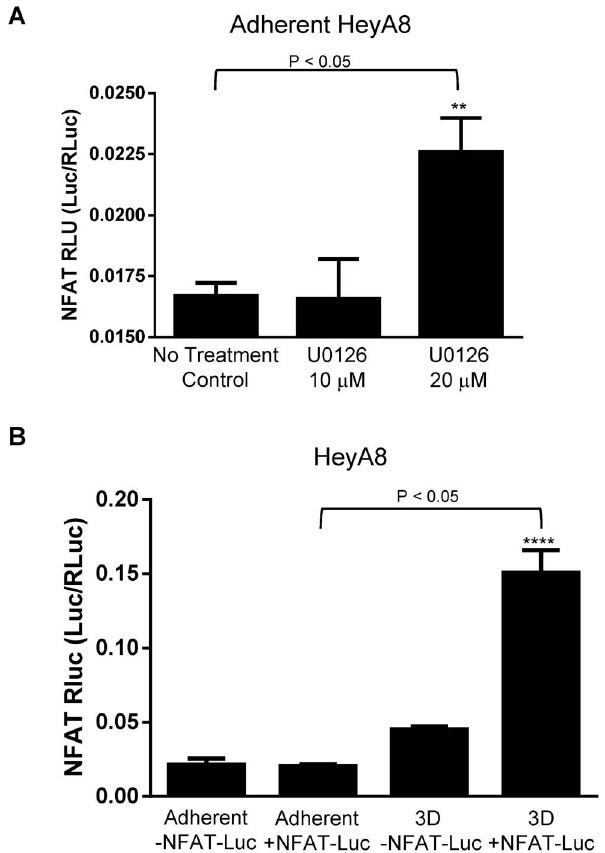
Fig. 7. ERK inhibition and 3D spheroids increased NFAT transactivation. HeyA8 cells plated at 50,000 cells in a 24 well plate for transfections. 500 ng of NFAT-Luc/Renilla mixture (40:1) were transfected per well and incubated overnight. U0126 were treated for 16-24 hours and 3D spheroids were formed for 48 hours prior to luciferase assay. ( A ) U0126 treated adherent HeyA8 cells showed slight significant increase of NFAT transactivation at the 20 m m but not at 10 m m. ( B ) 3D spheroid with + NFAT-Luc showed a greater increase in NFAT transactivation compared to adherent HeyA8 cells with + / 2 NFAT-Luc and 3D spheroid with no NFAT- Luc. (**, P , 0.05 vs no treatment control; ****, P , 0.05 vs. adherent + NFAT-Luc, 1-way ANOVA). The reporter assays are representative of 3